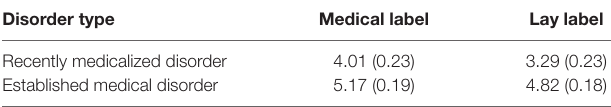
Table 1 | List of lay and medical labels used and associated category